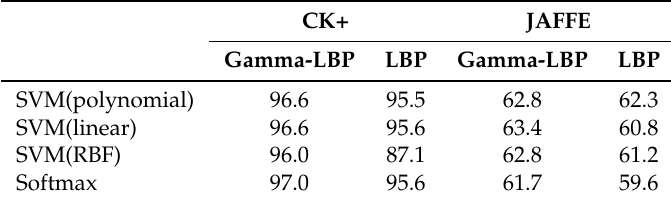
Figure 10. ( a ) Relationship between λ and σ on JAFFE database; ( b ) Relationship between λ and recognition rates from different classifiers on JAFFE database. Table 4. Recognition rates on different classifiers with and without gamma correction.